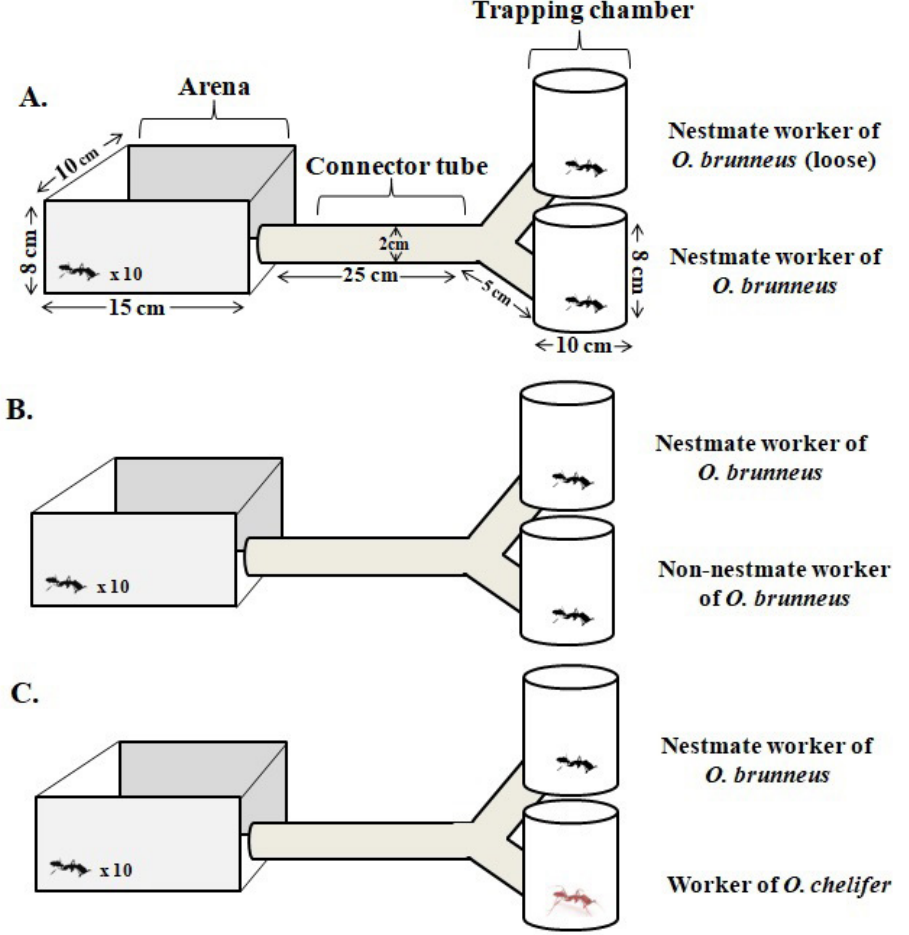
Fig 2 . Scheme used for the Y-maze decision tube tests with the rescue workers in the arena and the workers in the trapping chambers. A: Test with nestmate workers loose and trapped in the trapping chambers; B: Test with a trapped nestmate worker in one chamber and a trapped non-nestmate worker in the other chamber; C: Test with a trapped nestmate in one of the chambers and a trapped O. chelifer worker in the other